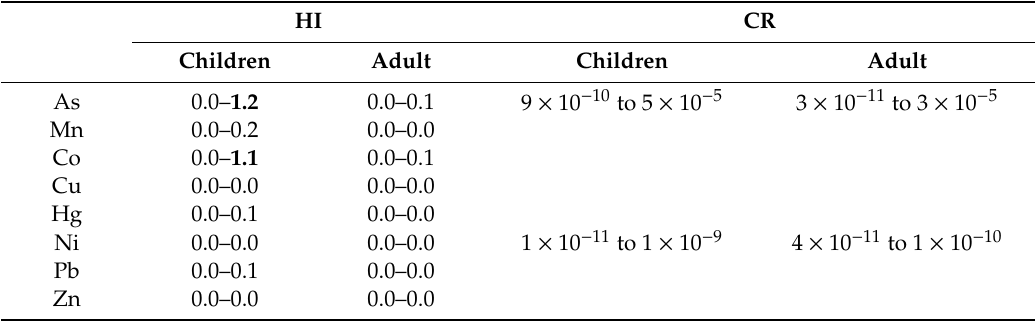
Table 2. Range of results obtained for Hazard Indexes (HI) and Cancer Risks (CR) due to sediment exposure for the di ff erent PTEs. Maximum results that are above the target values are in bold. HI